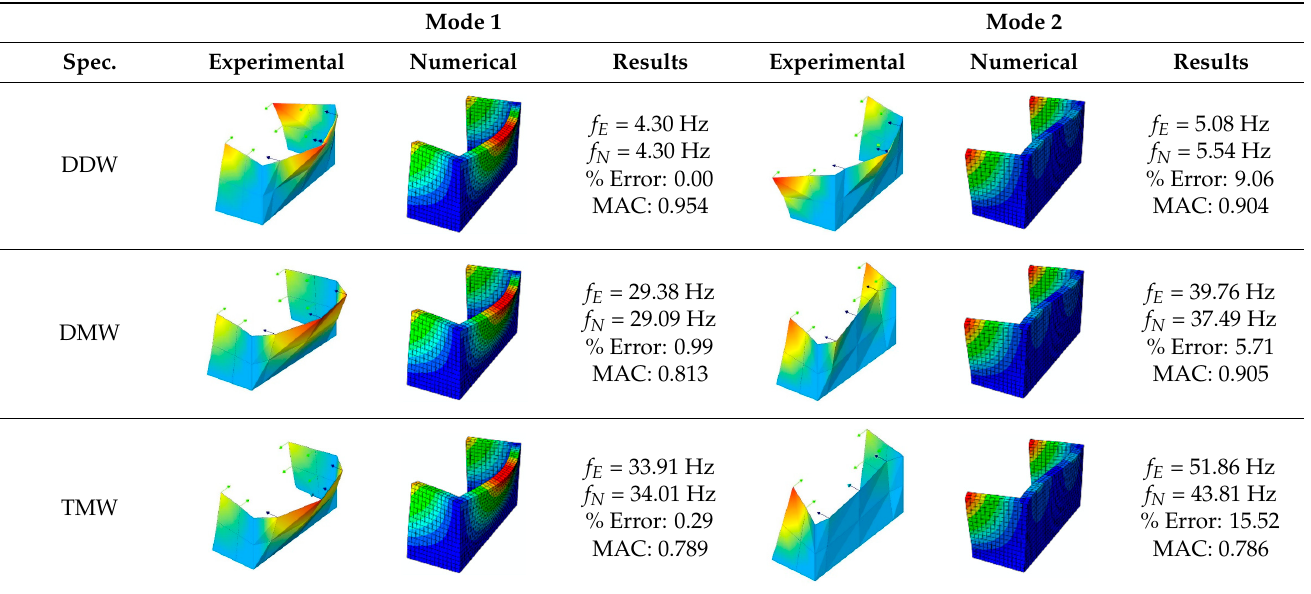
Table 1. Elastic material properties of initial FE models and the results of model updating.